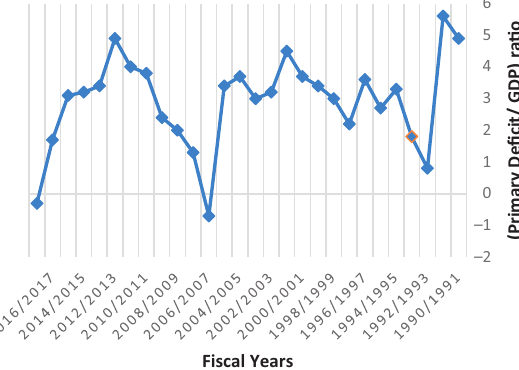
Figure 1. Evolution of